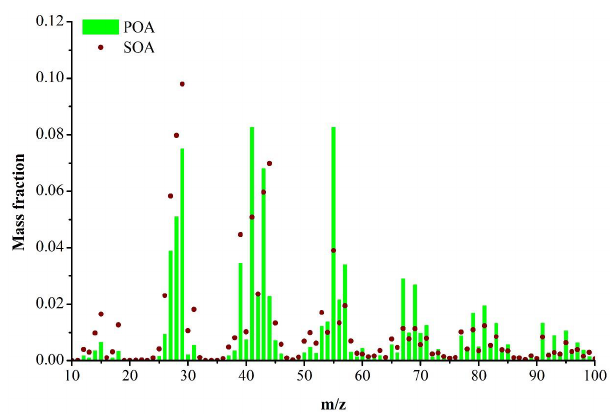
Figure 5. Mass spectra of POA and SOA at an OH exposure of 2 . 7 × 10 10 moleculescm − 3 s from heated canola